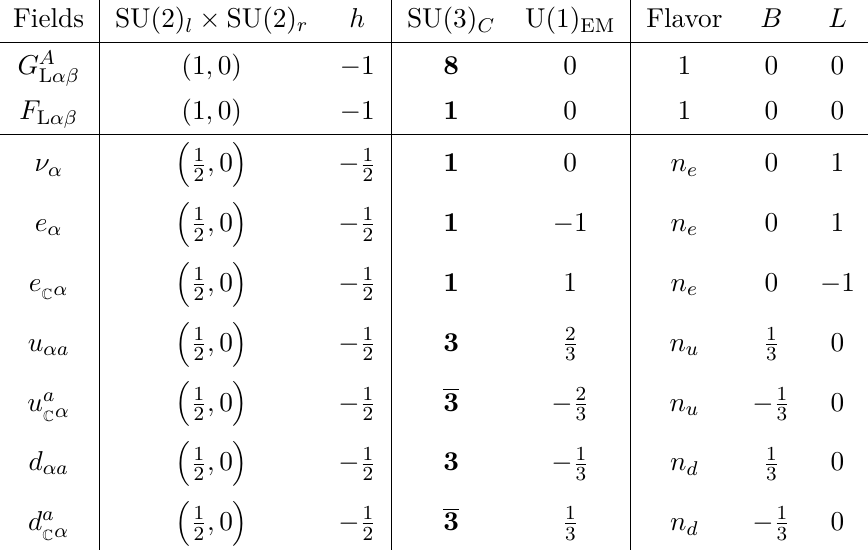
Table 1 . The field content of the LEFT, along with their representations under the Lorentz and gauge symmetries. The representation under Lorentz group is denoted by ( j ) , while the helicity l , j r of the field is given by h = j . The numbers of lepton flavors, u-type quark flavors and d-type r − j l quark flavors are denoted as n , n and n respectively with n = 3 , n = 2 and n = 3 in LEFT. e u d e u d Their global charges, baryon number B and lepton number L are also listed. All of the fields are accompanied with their Hermitian conjugates that are omitted, ( F ) † = F for gauge bosons L αβ R ˙ α ˙ β and ( ψ ) † = ( ψ † ) for fermions, which are under the conjugate representations of all the α ˙ α